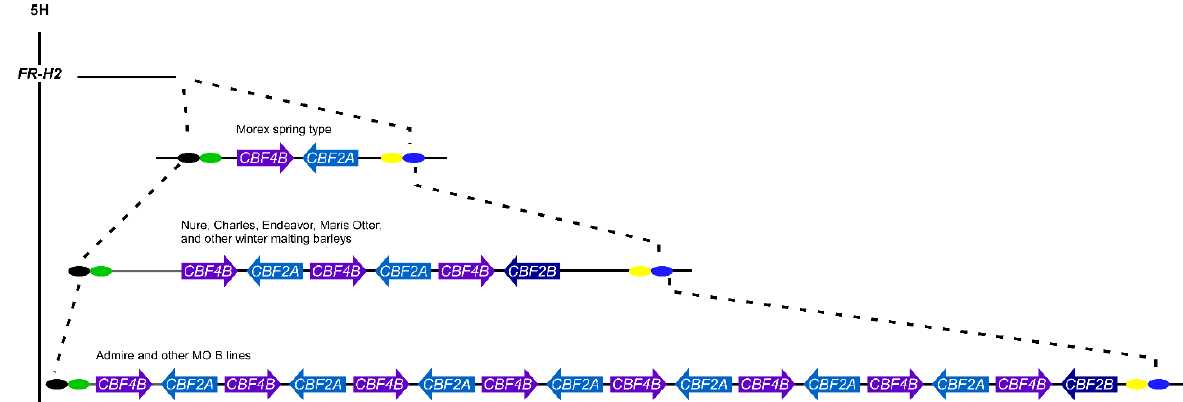
Figure 5. Illustration of the 22 kb CBF2A–CBF4B genomic region copy number variable unit. Top depicts the Morex-like spring allele. Middle shows the Nure allele as determined from sequencing BAC clones [137], which is predicted to be representative of current winter malting barley lines based on sequencing, DNA blot hybridization, pedigree, or any combination of these [100]. Lower allele depicts hypothesized Admire allele, which were estimated by DNA blot hybridization and following the structural organization pattern revealed by Mareri et al. with the centromere toward the north on the vertical illustration and left on the horizontal illustration [135,137]. Other MO B lines possess copy numbers that are intermediate between Admire and the Dicktoo-Nure allele [135]. The colored ovals are used to illustrate a common region across genotypes outside the iterated 22 kb CBF2A–CBF4B genomic region. For example, the green oval identifies a region containing a Xba I site that is common across genotypes having the Dicktoo-Nure allele, which is 6.0 kb from an Xba I site in the iterated region. Using a CBF4 coding sequence probe on an Xba I digest in DNA blot hybridizations results in a single copy 6.0 kb MW fragment, and a multi-copy 9.3 kb fragment.